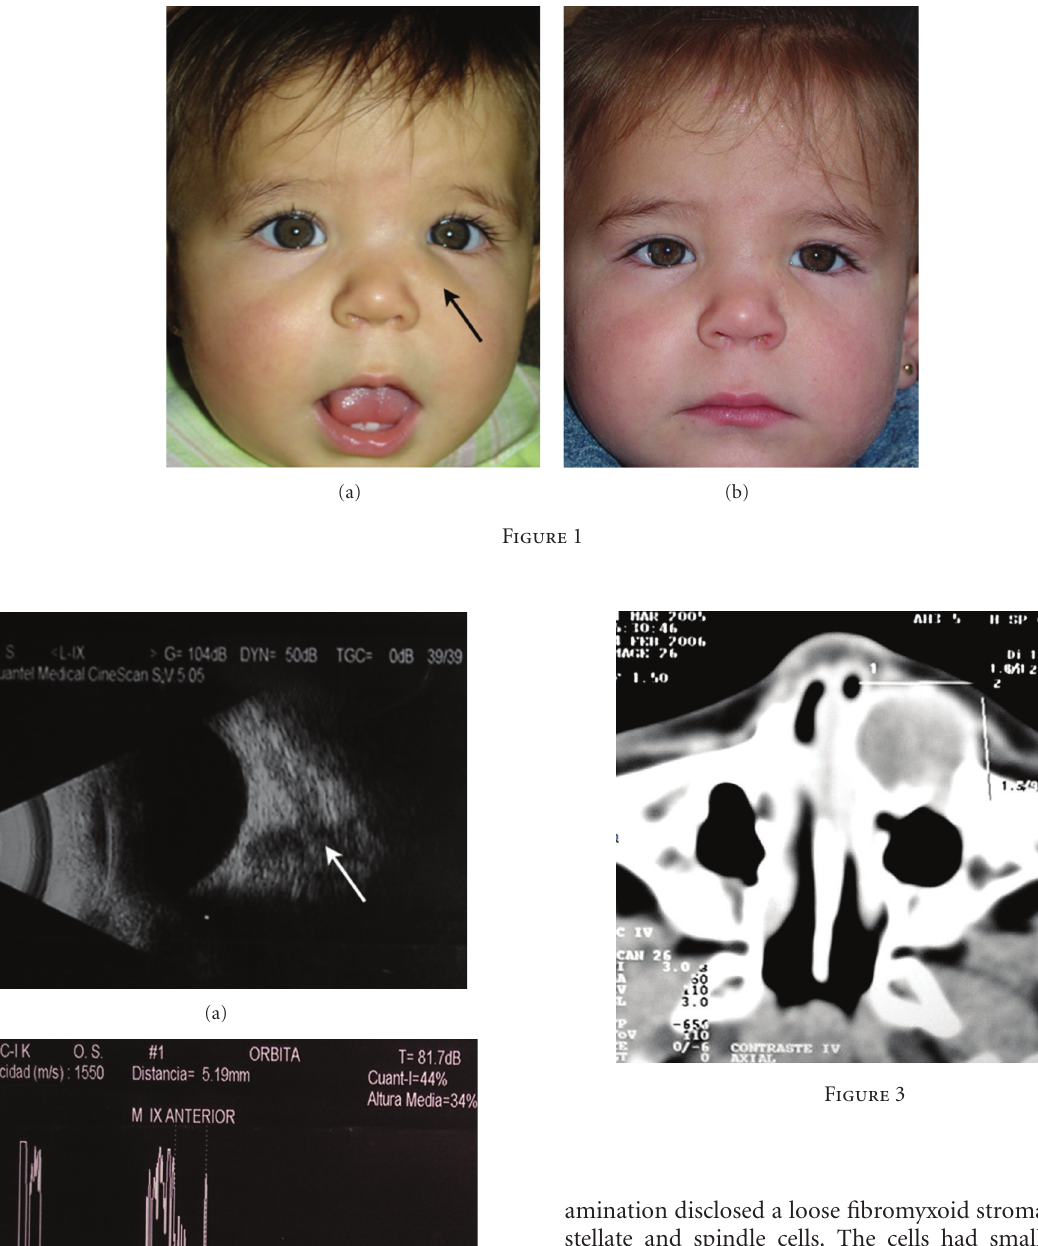
amination disclosed a loose fibromyxoid stroma with sparse stellate and spindle cells. The cells had small hyperchro- matic nuclei, fine chromatin, and basophilic stellate cyto- plasm. There was no cellular pleomorphism or nuclear atypia. No obvious mitotic figures or necrotic areas were observed (Figure 5). Special stain for mucin by alcian blue was strongly positive in the loose stroma confirming the acid mucopolysaccharide nature of the tumor (Figure 6). Immunohistochemically, the cytoplasm of the stellate and spindle cells was strongly positive for vimentin and negative for desmin, S-100 and GFAP (Figure 7). The histopatho- logical and immunohistochemical features were consistent with the diagnosis of periocular myxoma, and ruled